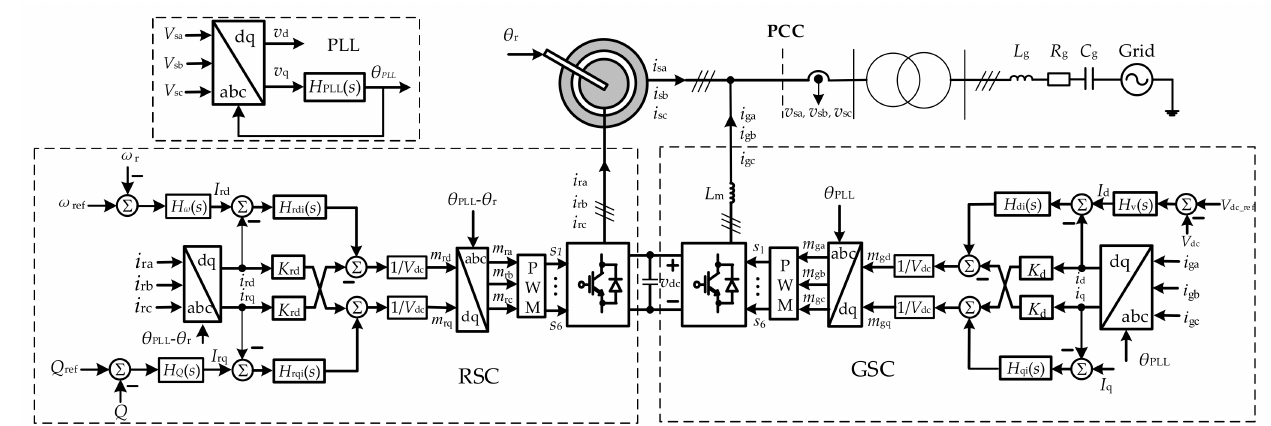
Figure 1. Circuit topology and control block diagram of